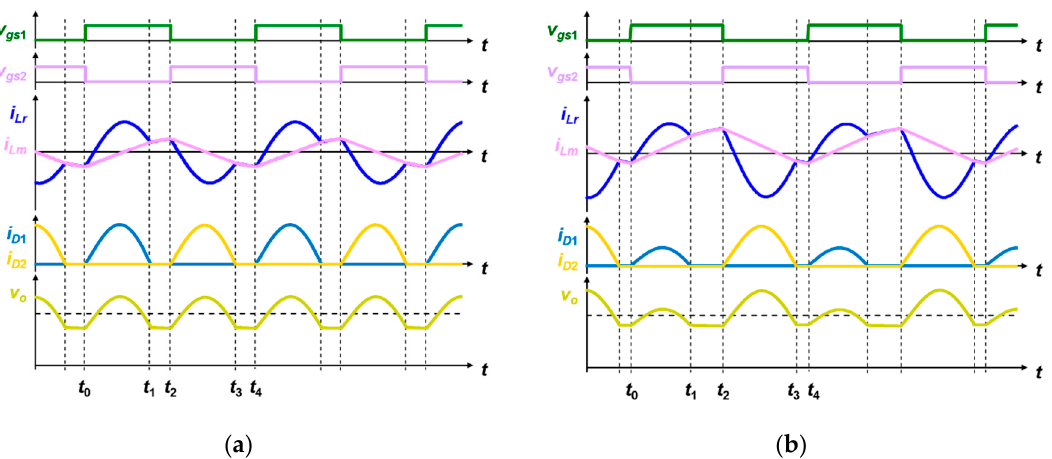
Figure 2. Key waveforms of the LLC resonant converter operating below the resonant frequency with the different leakage inductances in the secondary side windings ( a ) matched leakage inductances and ( b ) mismatched leakage inductances.